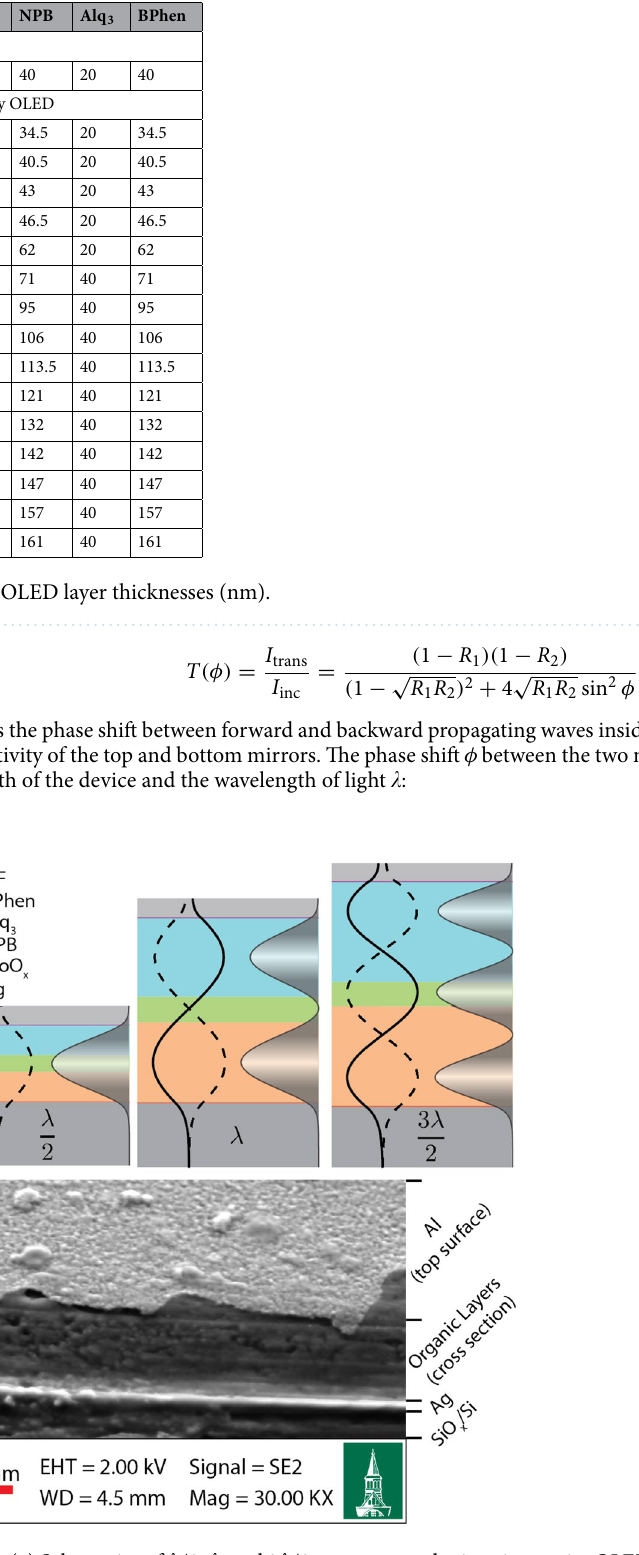
Figure 1. ( a ) Schematics of (cid:31) / 2 , (cid:31) , and 3 (cid:31) / 2 resonant modes in microcavity OLEDs. Materials with representative thickness in the schematics are color-coded. The standing-wave electric field and the intensity are computed (as described below) for the observed resonant wavelength and plotted to illustrate the three resonant modes. ( b ) Cross-sectional SEM image of a 308 nm thick microcavity OLED. Cross section was prepared by scribing the surface and is not a vertical cross section. Image taken at 45 ◦ tilt shows top cutaway organic layers and top surface of the 30 nm thick Al top electrode.